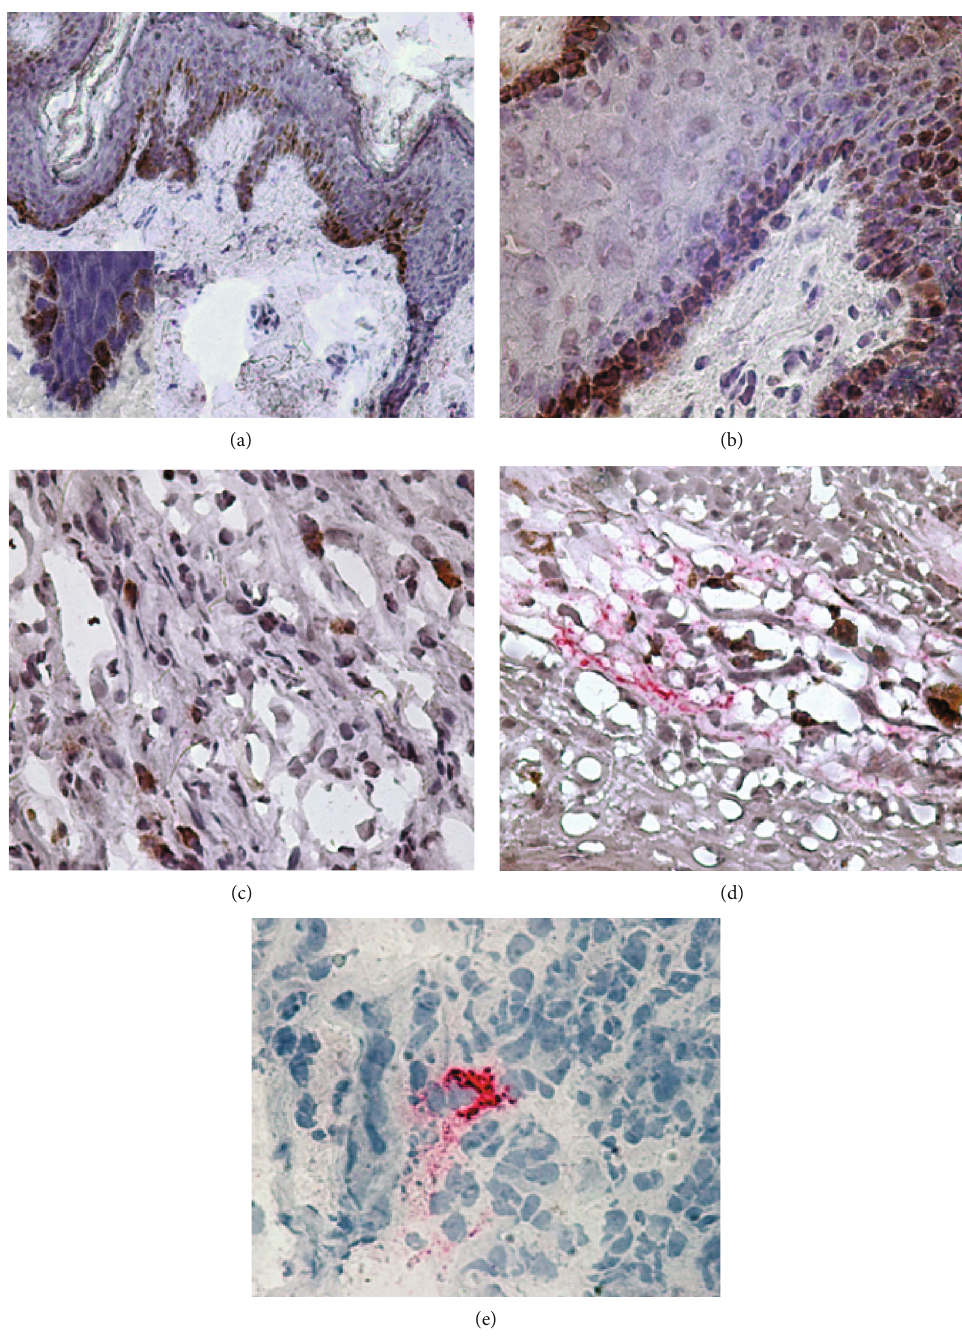
Figure 2: In situ detection of insulin-like growth factor (IGF)-I and Leishmania antigens in the in fl ammatory in fi ltrate of cutaneous leishmaniases lesions caused by L. ( Viannia ) braziliensis. IGF-I (brown) and Leishmania antigens (red) are expressed in normal skin (a) and cutaneous leishmaniases lesions (b – e). IGF-I is present in the basal layer in normal skin (a) and in CL lesions (b). In CL lesions, IGF-I is present in the dermis (c). IGF-I was observed close to Leishmania antigens in the dermis (d). Leishmania antigens were observed in the dermis (e). Representative photos of immunohistochemical analysis. Original magni fi cation ×